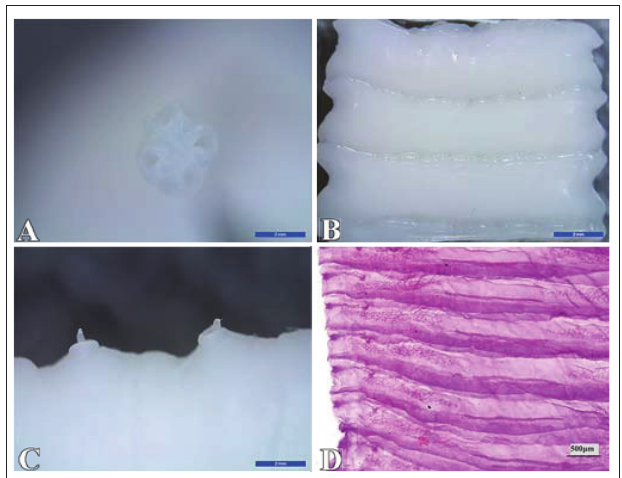
FIGURE 1 | Identification of Moniezia benedeni . (A) scolex; (B) strobila; (C) germ antrum; (D) interproglottidal glands. The scale bar of (A), (B) and (C) is 2 mm, and (D) is 500 µ m.